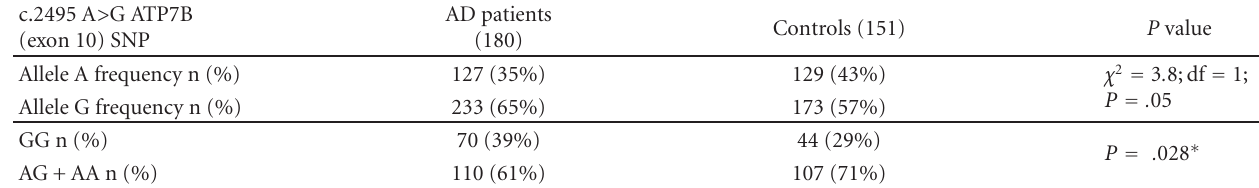
Table 4: c.2495 A > G ATP7B (exon 10) SNP allele distribution in AD patients and healthy controls and comparison between GG versus AG + AA.